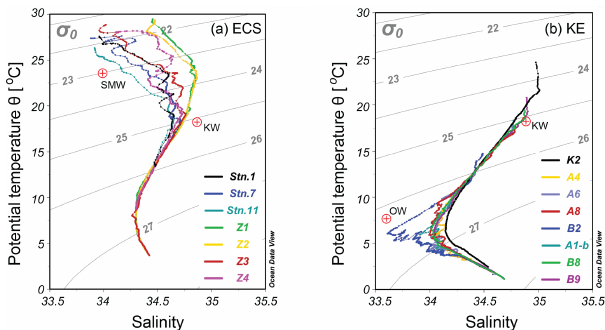
Figure 2. Potential temperature vs. salinity ( T – S ) diagrams for the sampling stations. (a) Seven shelf-edge to slope stations in the ECS and (b) eight deep stations in the KE region in the northwestern North Pacific. σ 0 isolines are included in the figures. The coloured lines correspond to CTD data, and red dots indicate the potential temperature ( θ ) and salinity ( S ) of different water masses. The rep- resentative θ and S of these water types referred to previous stud- ies (Yasuda et al., 1996; Chen and Wang, 1999; Hung et al., 2003; Wong et al., 2007). Acronyms used in this figure: SMW – shelf mixed water, KW – Kuroshio Water and OW – Oyashio